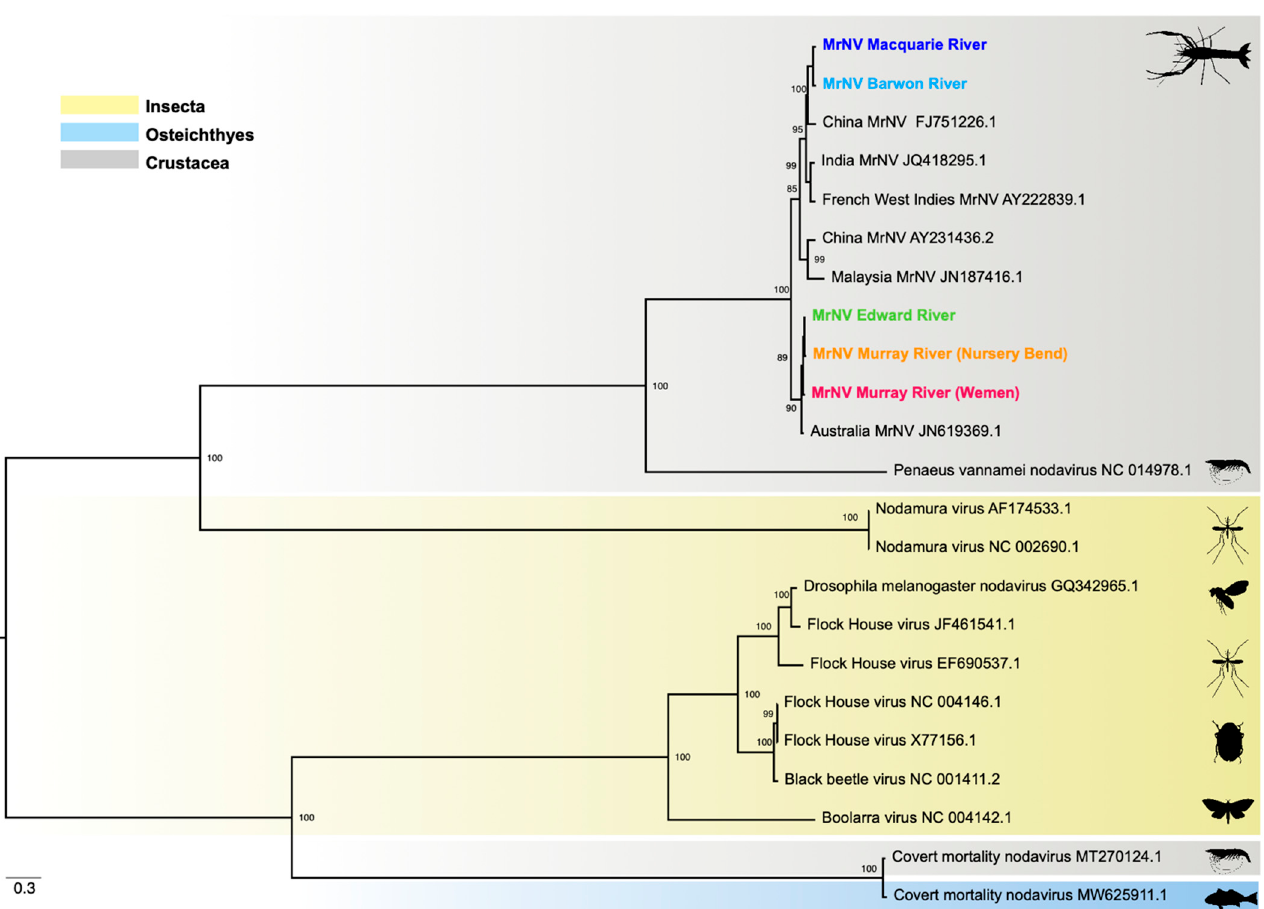
Figure 4. Maximum likelihood tree of the RdRp gene (3126 bp) of MrNV and related alphanodavirus sequences. The viruses detected are colour-coded to match Figure 1. The phylogeny is midpoint- rooted for clarity only and scale bar represents nucleotide substitutions per site. Tip labels represent virus name and NCBI/GenBank accession ID.